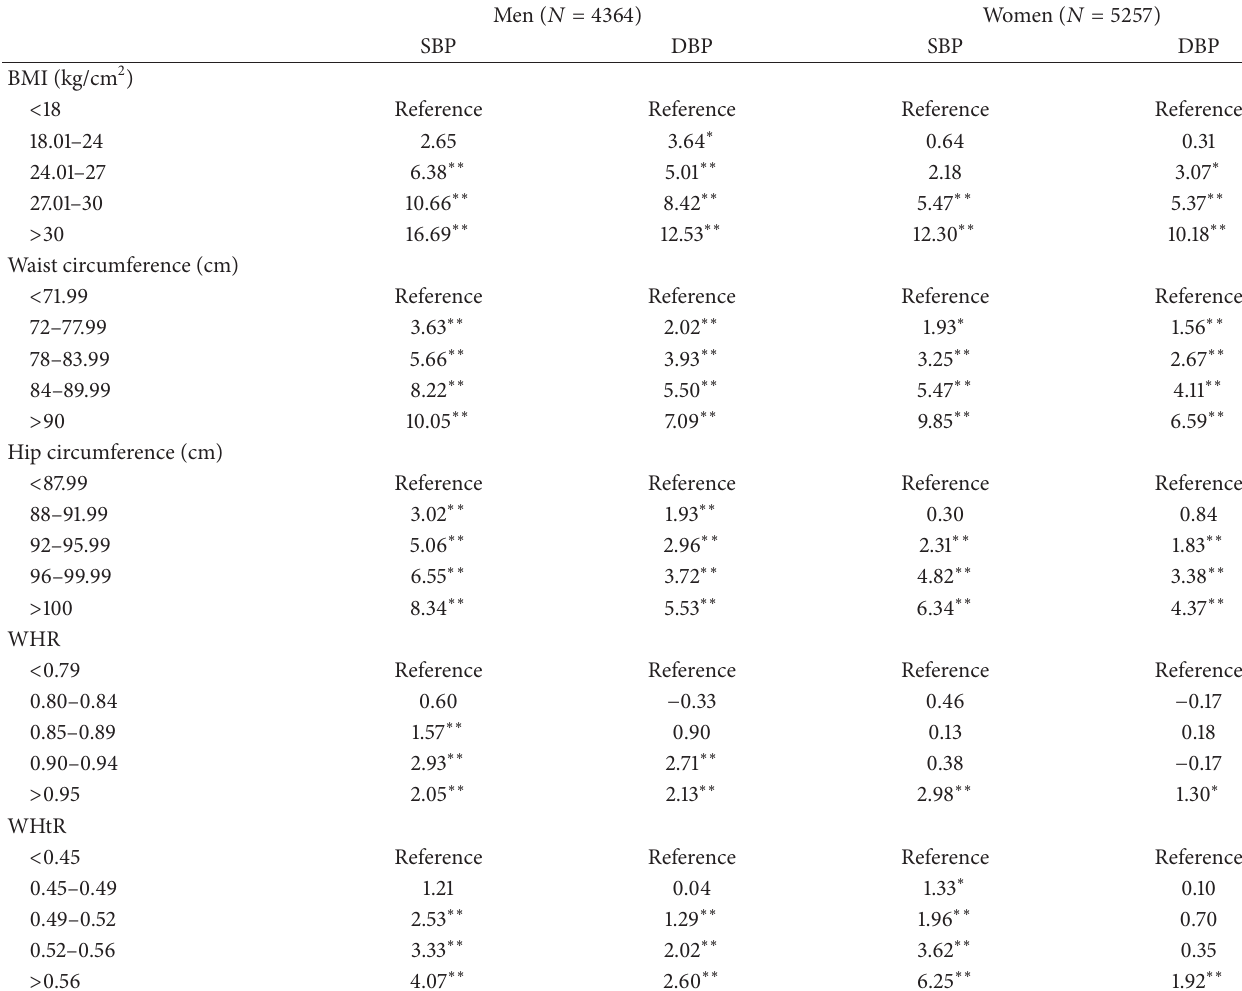
Table 2: Anthropometric indices dose-dependently correlated with systolic BP and diastolic BP across gender, adjusted for age, race, education, and occupation using multiple linear